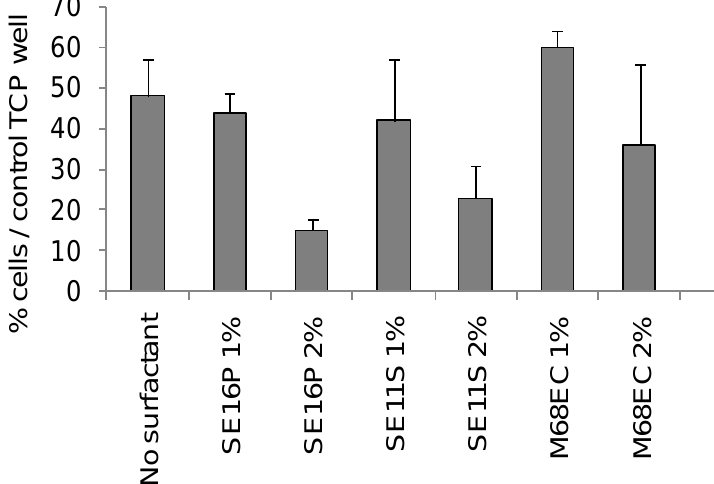
Figure 5. Osteoblast viability measured by MTT assay as a function of surfactant concentration.